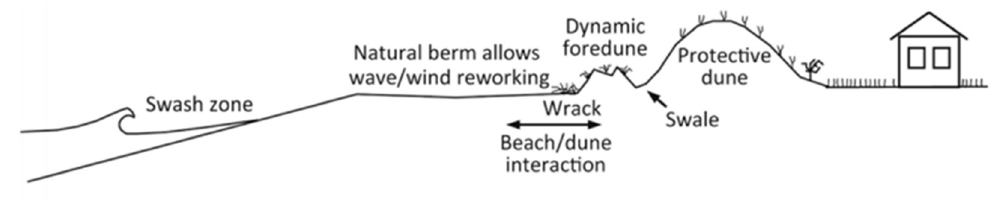
Figure 11. Use of sand dunes for protection against storm surge.